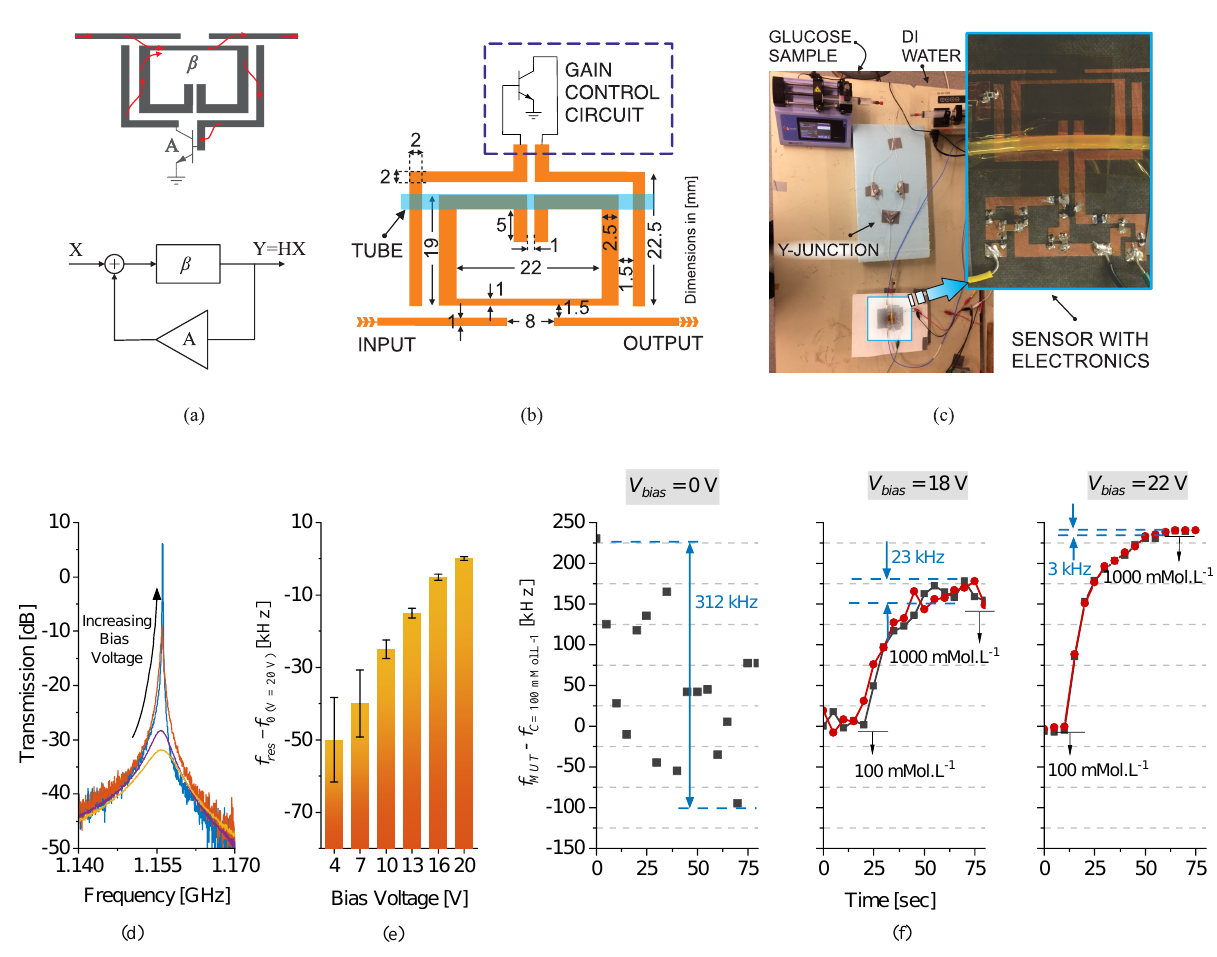
Figure 40. Active sensor design, schematic and preliminary results: ( a ) feedback schematic of an active resonator; ( b ) schematic of the active resonator with dimensions; ( c ) Sensing setup for glucose monitoring with two syringe pumps; ( d ) bias voltage impact on the transmission response; ( e ) bias voltage impact on the sensor response uncertainty; ( f ) monitoring glucose concentrations (100 → 1000 mg · dL − 1 ) with different states of the active sensor ( V bias = 0,18,22 V) with two separate measurements (black and red lines). Reprinted with permission from Ref.